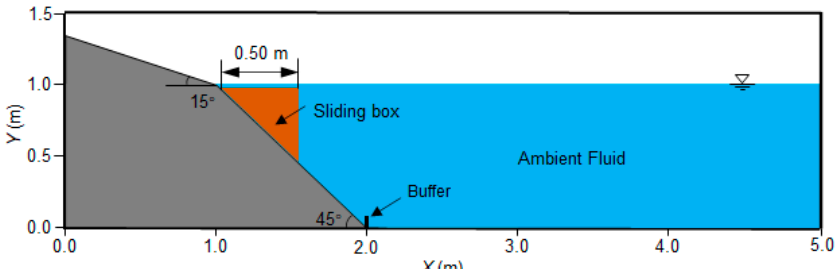
Figure 4. Experimental setup of an underwater rigid block sliding along an inclined plane. Table 1. Parameters used in the SPH simulation of the rigid block sliding experiment.